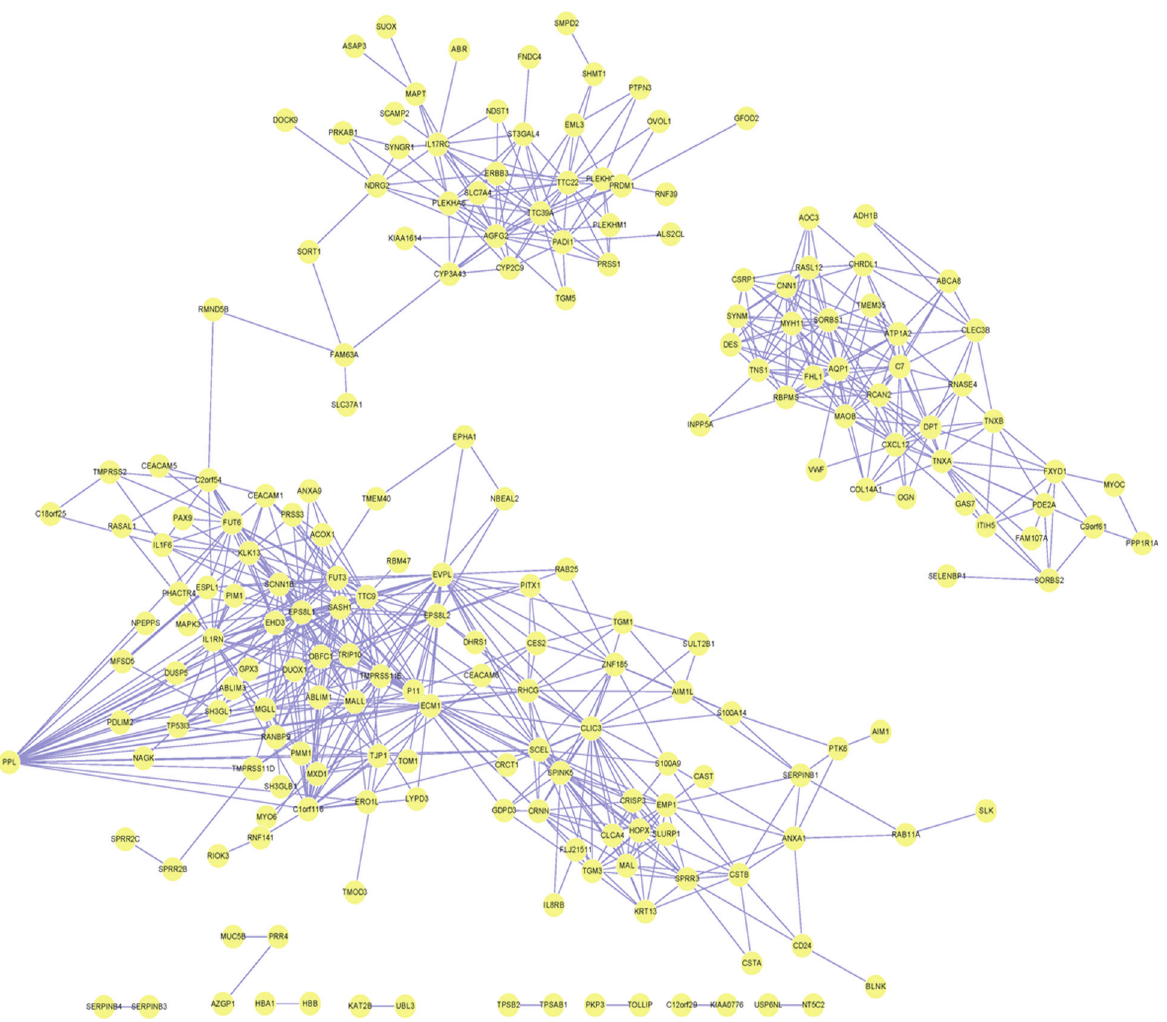
Figure 3 - Correlation network of ESCC. Yellow dots indicate DEGs and blue lines the correlation of two neighboring points, with r >